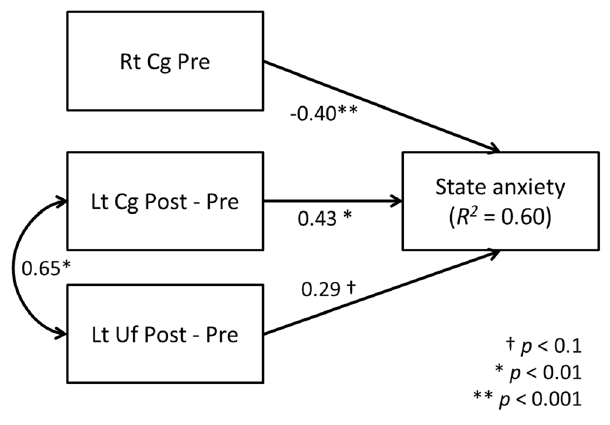
Figure 2. SEM implemented on a path diagram. The strength of the path coefficients between state anxiety scores and Pre FA in the right anterior Cg ( 2 0.40, p , 0.001) and between state anxiety scores and Post–Pre FA in the left anterior Cg (0.43, p , 0.01) and the left Uf (0.29, p =0.06) are shown. The path coefficient strength between Post– Pre FA in the left anterior Cg and the left Uf (0.65, p , 0.005) are shown as well. The brain regions that predict state anxiety level evaluated by STAI are shown on the left. FA, fractional anisotropy; Rt, right; Lt, left; Cg, cingulum; Uf, uncinate fasciculus; STAI, State–Trait Anxiety Inventory.